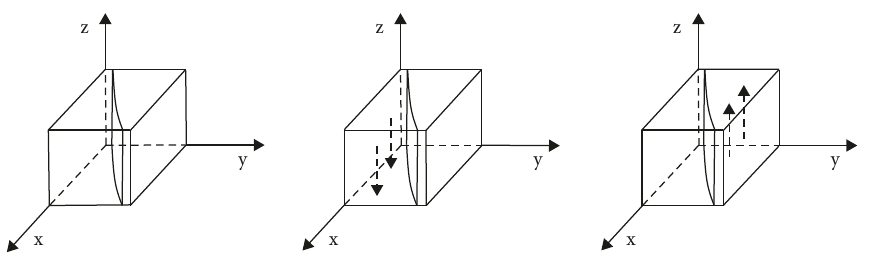
Figure 3: Dynamic replication phase diagram of the evolution of the public’s strategic